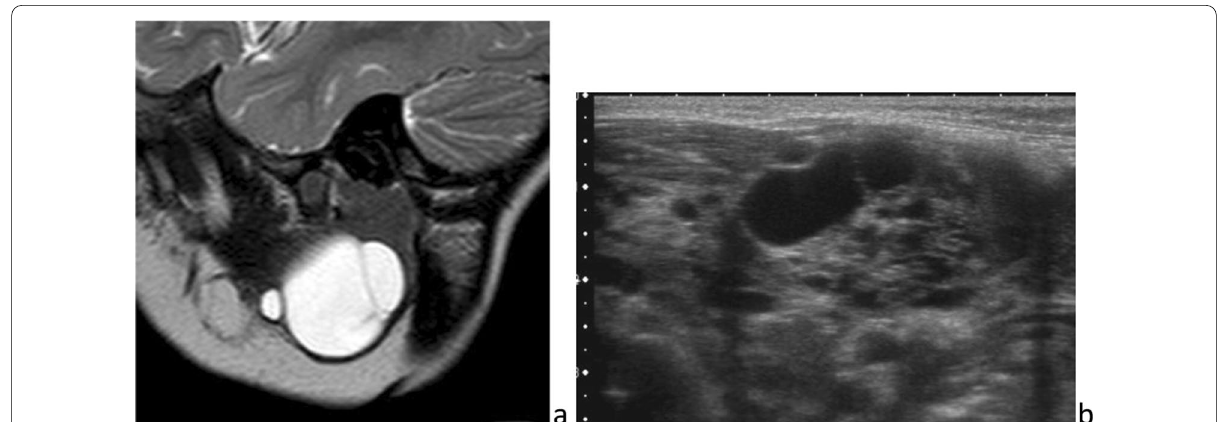
Fig. 9 Lymphatic malformations. Macrocystic lymphangioma on parasagittal T 2 ‑weighted image ( a ) and micro‑ and macrocystic lymphangioma on ultrasonography ( b )